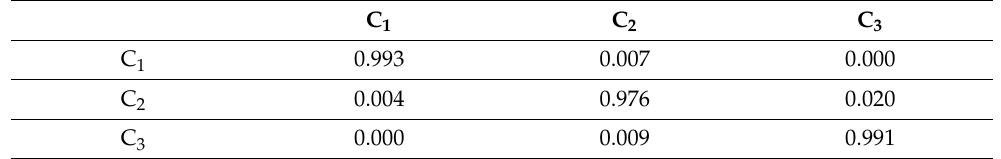
Table 5. The probability of latent profile analysis.